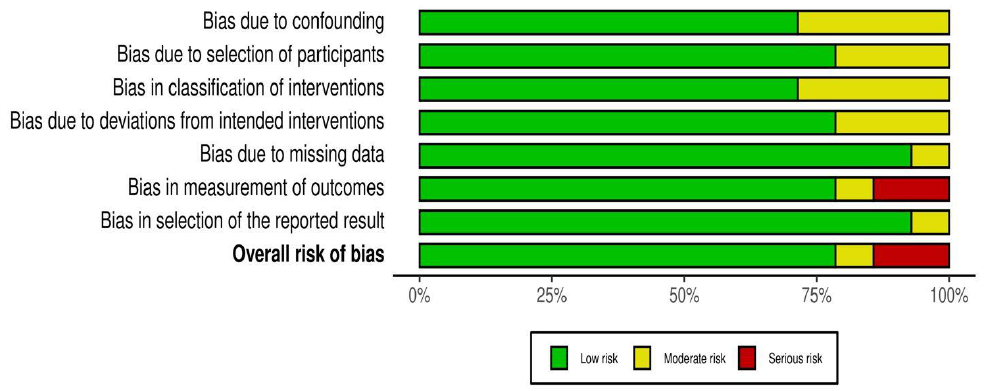
Figure 3. Summary plot of the overall risk of bias.